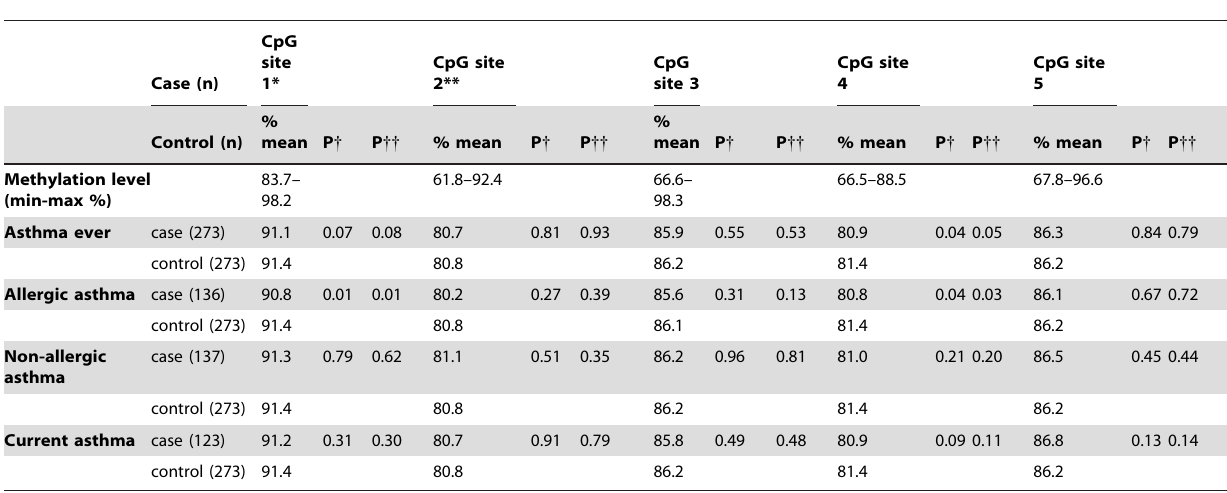
Table 4. DNA methylation status compared between asthma cases and controls in the BAMSE cohort (n=546) using adjusted linear regression